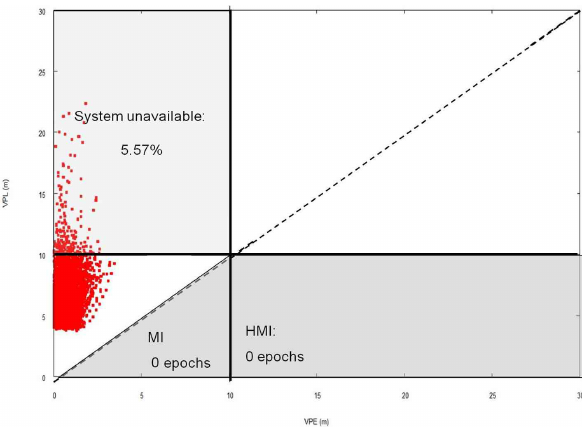
Figure 6: Stanford diagram comparing the true error and the pro- tection level on the vertical